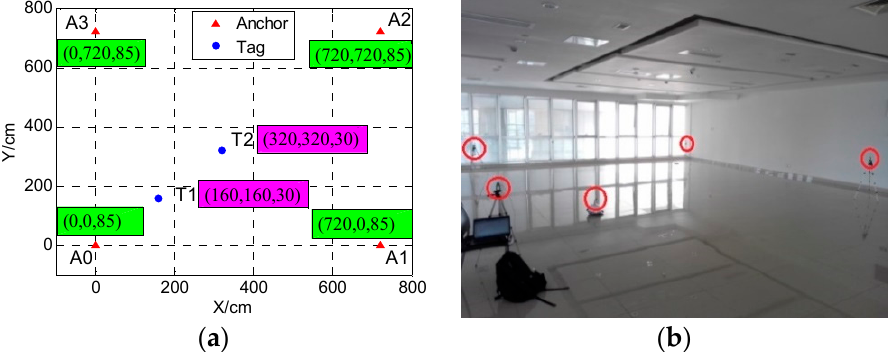
Figure 6. The locations of test points and anchors ( a ) and the experimental scene ( b ).